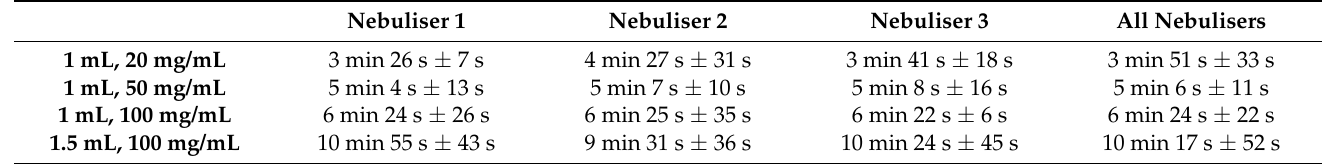
Table 4. Nebulisation duration of the dose output